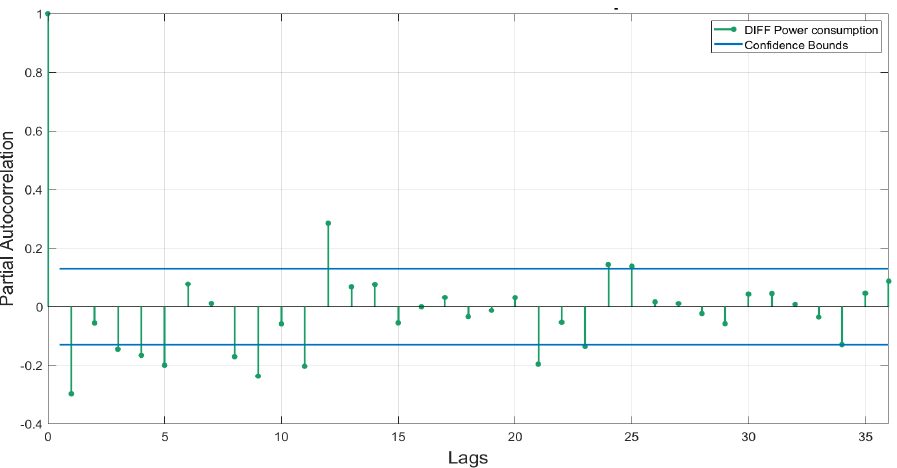
Figure 5. Partial auto-correlation PACF for Diff Data for monthly power consumption in Quito, Ecuador between January 1999 and December